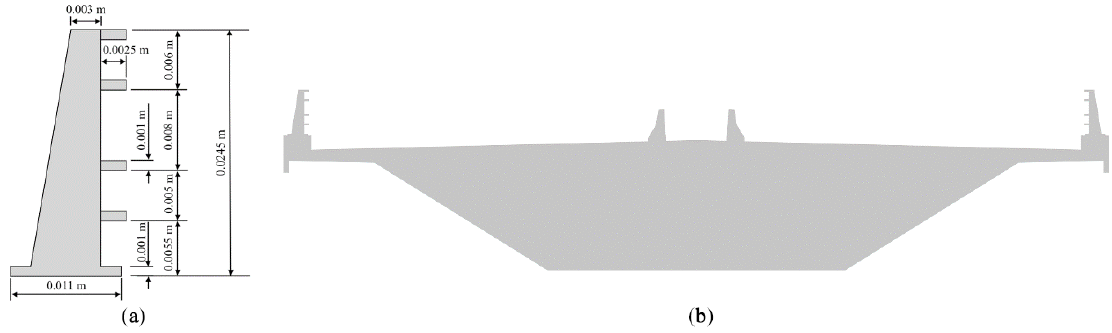
Figure 27. Handrails of the bridge deck: ( a ) Dimensions of handrails; ( b ) Locations of handrails on the shallow deck with vertical fascia beams.